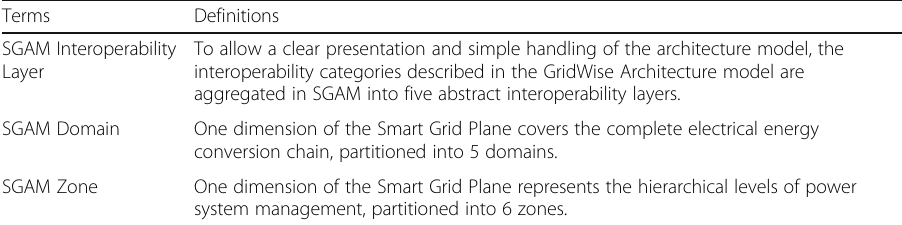
Table 8 Table Styles Terms and Definitions in the SGAM Framework (CEN-CENELEC-ETSI Smart Grid Coordination Group